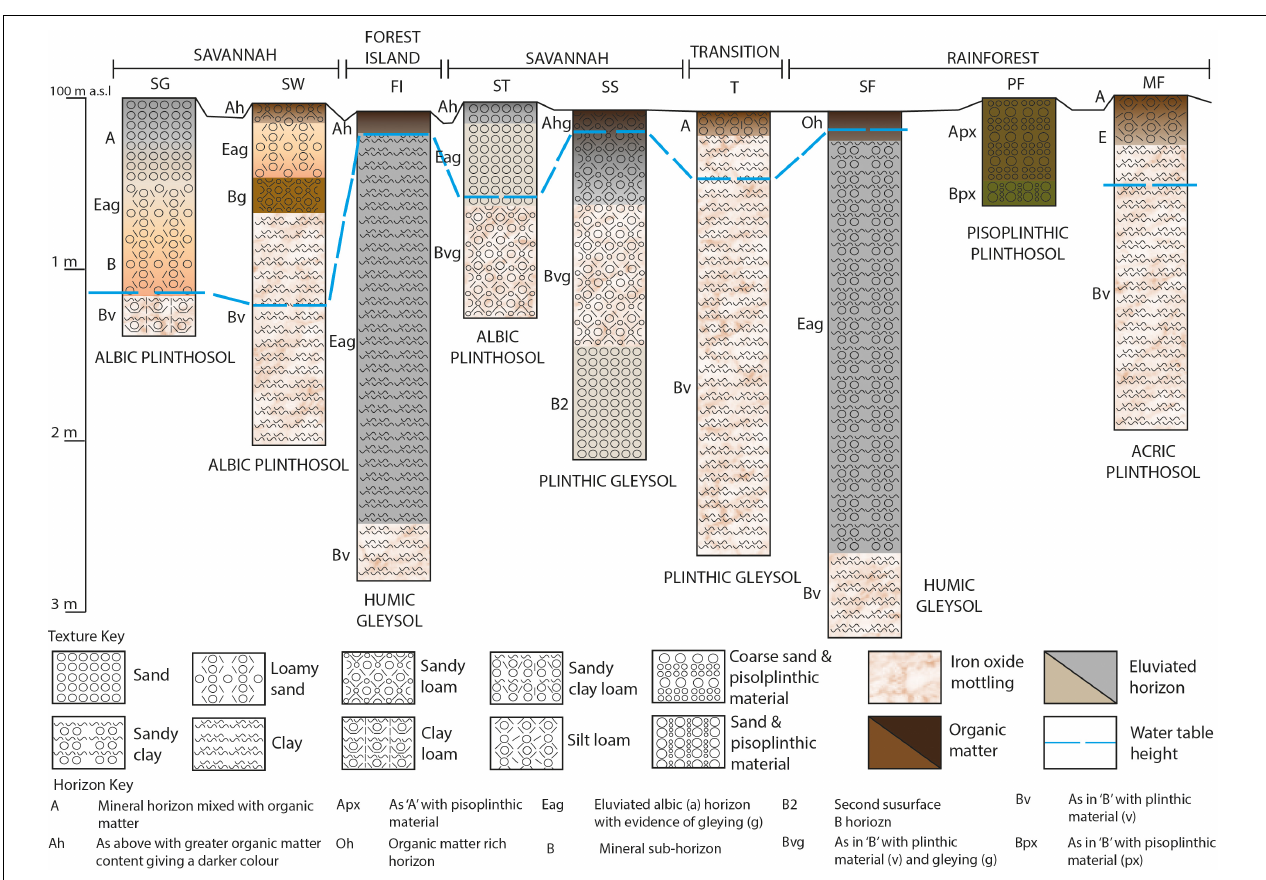
FIGURE 2 | Schematic of the sequence of sub-environments sampled along the 5 km transect in Wowetta. SG, Savannah Grassland; SW, Savannah Woodland; FI, Forest Island; ST, Savannah Tree; SS, Savannah Swamp; T, Transition zone; SF, Swamp Forest; PF, Pisoplinthic Forest; MF, Mixed Forest.